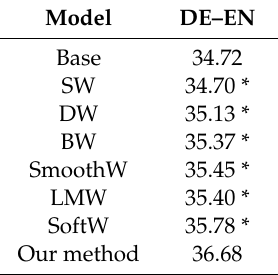
Table 1. The BLEU score of di ff erent data